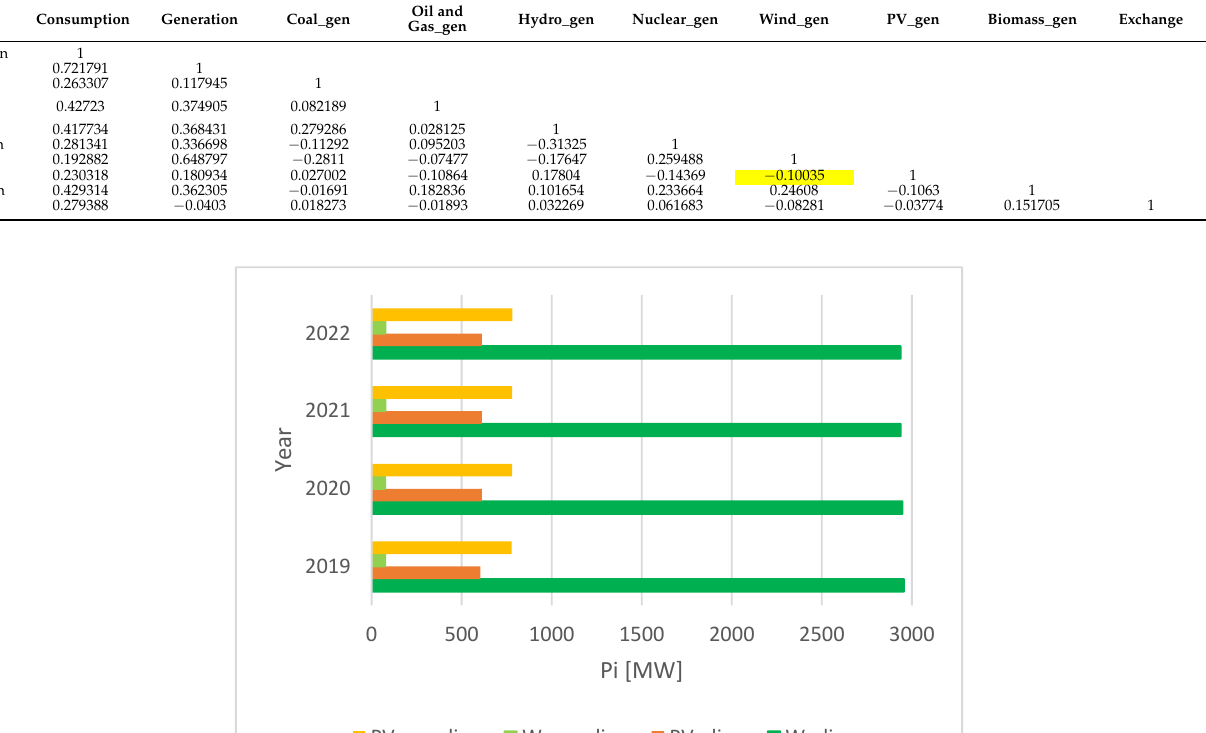
Hour COG and RES in 2019 Average of Coal_gen Average of Oil&Gas_gen Average of Wind_gen Average of PV_gen